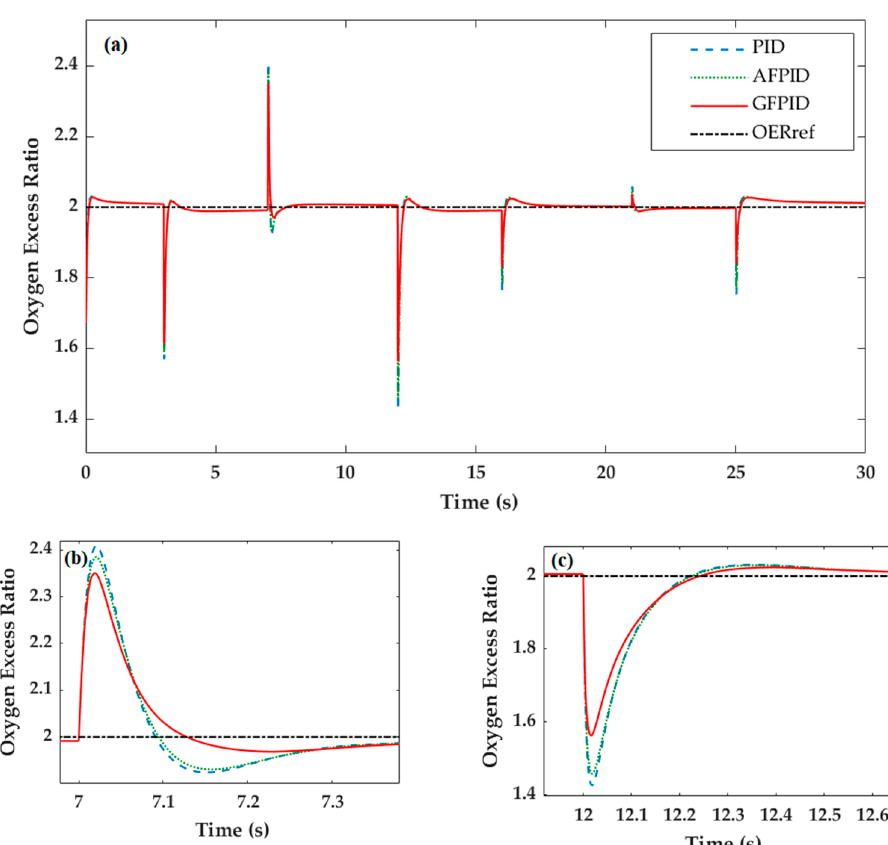
Figure 12. Response of λ O at constant λ o : ( a ) comparison of simulation; ( b ) zoom in current 2 2 ,ref step-down at 7 s; ( c ) zoom in current step-up at 12 s.